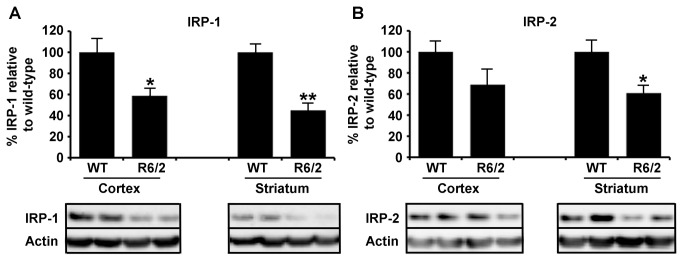
Decreased expression of iron-response proteins IRP1 and IRP2 in R6/2 HD mice.
A. IRP-1 protein expression in cortical and striatal separated brain tissue was significantly decreased in 12-week-old R6/2 mice compared to age-matched wild-type littermate controls. B. To a lesser extent IRP-2 expression was also decreased in HD model tissue from the same mice but did not reach significance in cortical regions. P-values: *<0.05, **< 0.01, n=5.